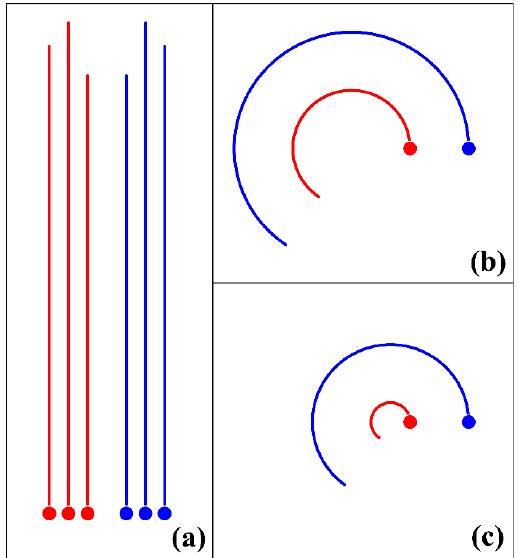
Figure 2. The initial portions of trajectories of two-layer point vortex structures. The red and blue lines depict the trajectories of cyclonic eddies of the upper layer and anticyclonic eddies of the middle layer, respectively. ( a ) Translations with velocity (2) at L = 0.56 (middle pair), L = 0.28 (inner pair) and L = 0.84 (outer pair) for the same duration (cf. the three markers on the green curve in Figure 1); ( b ) rotations with angular velocity (4) relative to the center of vorticity (6) for L = 2.00 = − 1/2; ( c ) same as ( b ) but for Λ 1 = − 1/4. Red and blue markers identify the initial and Λ 1 / Λ 1 / Λ 1 2 2 1 1 positions of the vortices of the upper and middle layers,